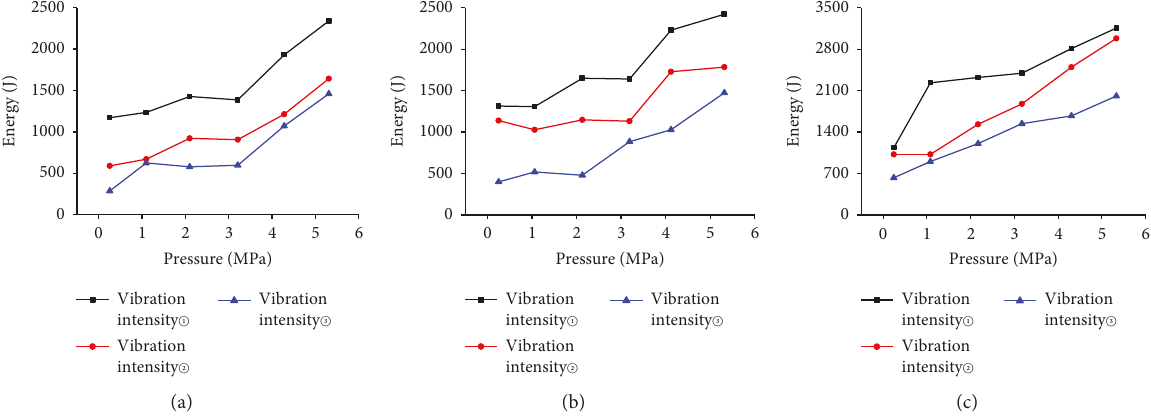
Figure 14: Total energy analysis. (a) Intact model. (b) Damage model. (c) Failure